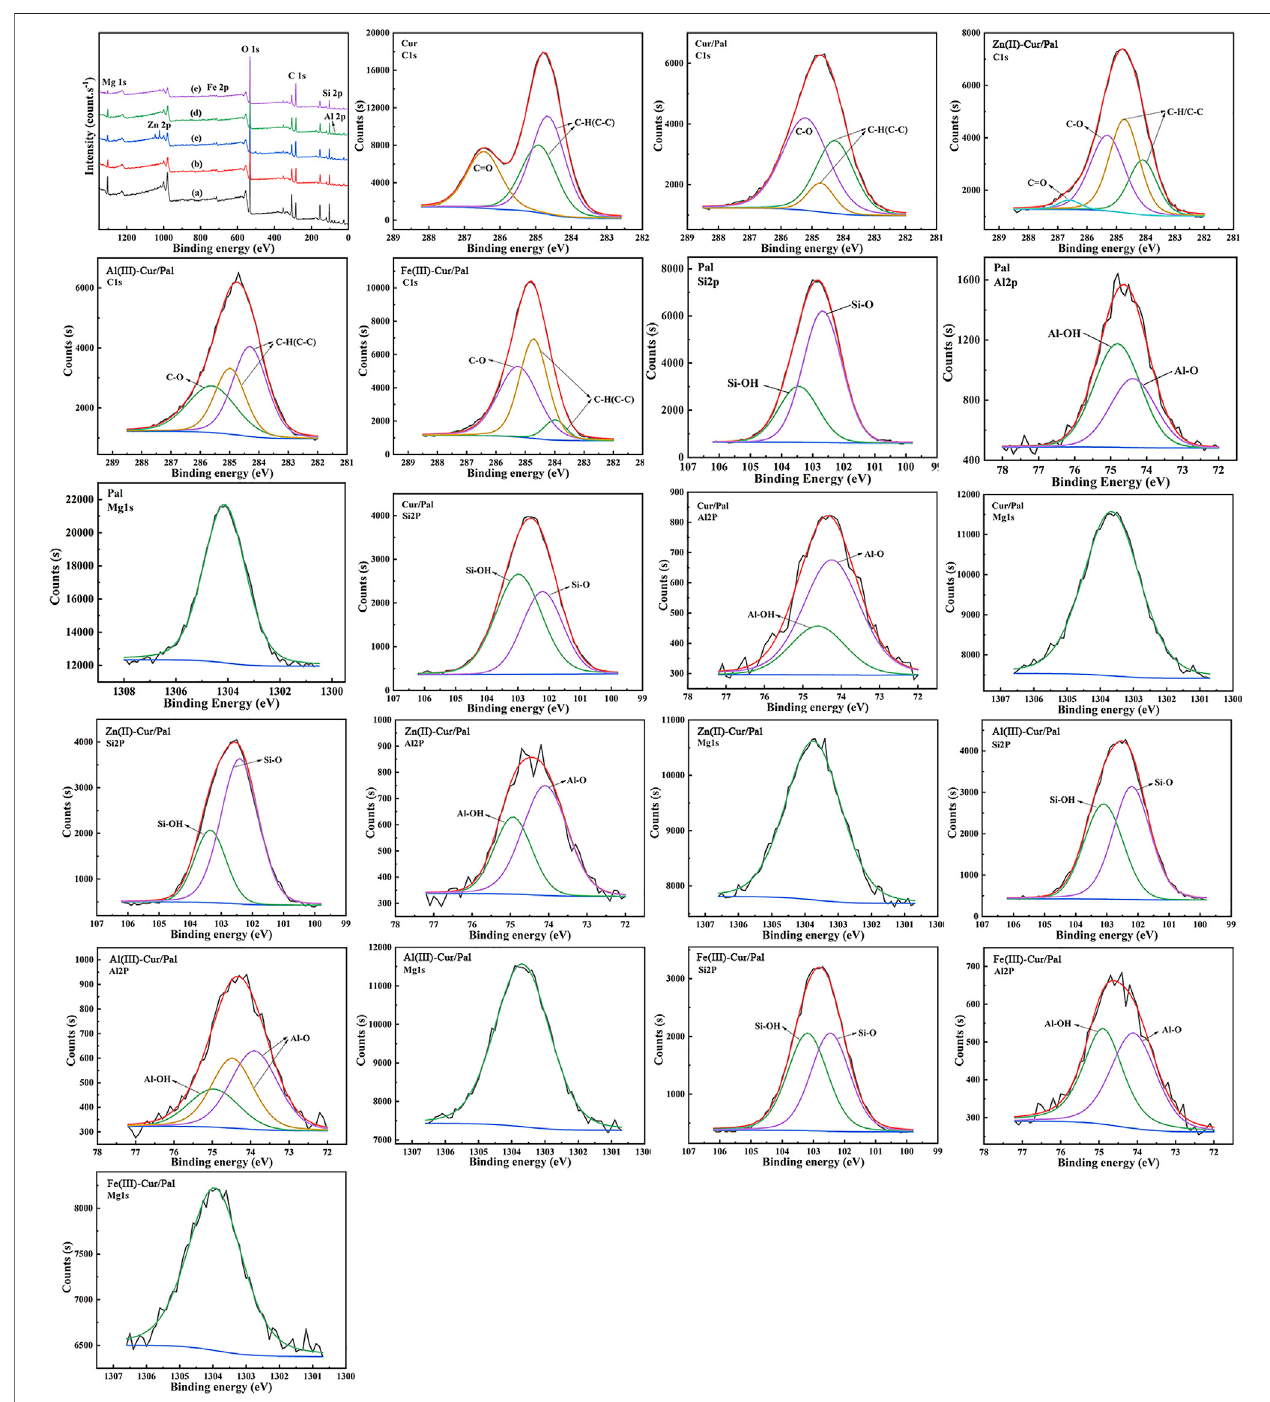
FIGURE 4 | XPS survey of Pal (a) , Cur/Pal (b) , Zn(II)-Cur/Pal (c) , Al(III)-Cur/Pal (d) , and Fe(III)-Cur/Pal (e) and high-resolution XPS spectra of C1s, Si2p, Al2p, and Mg1s.